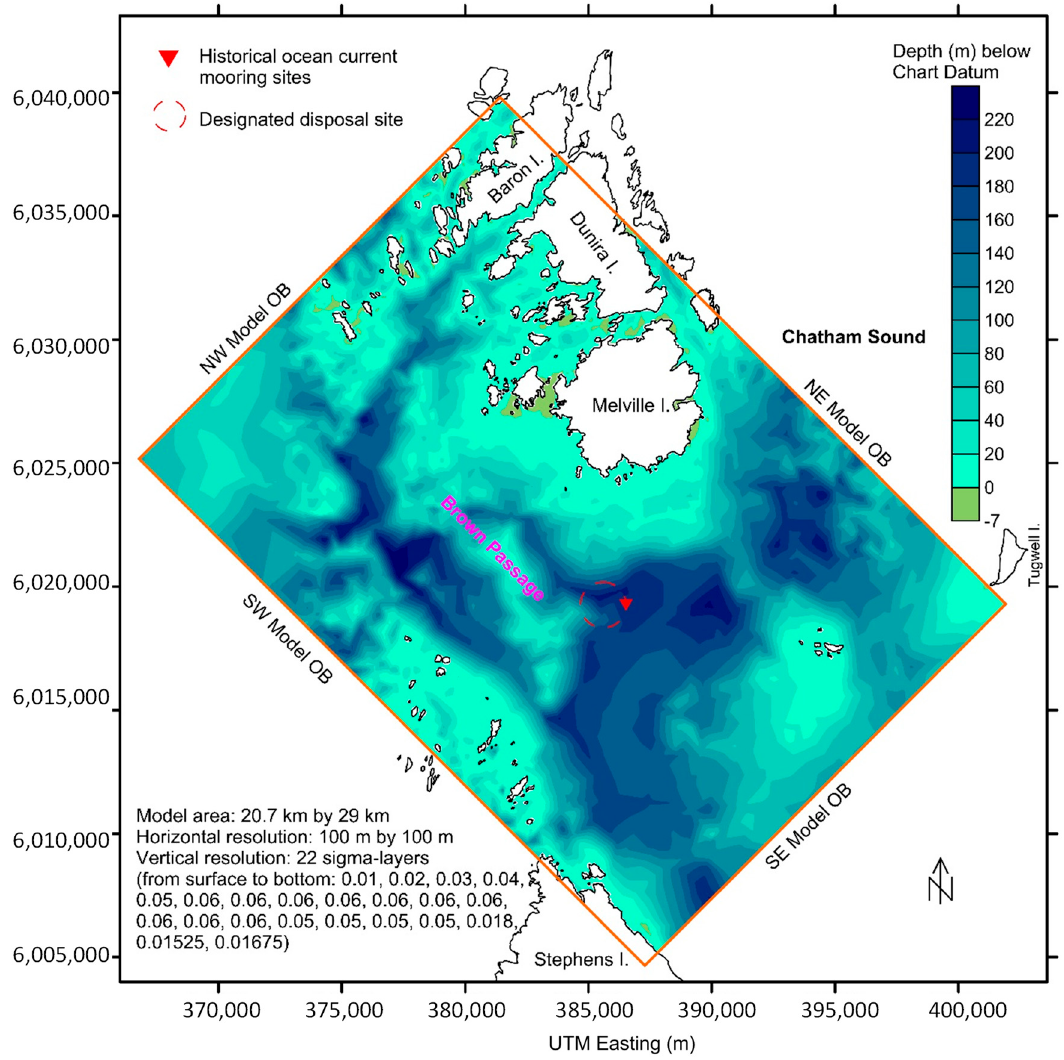
Figure 4. A map of water depths in Brown Passage (meters below chart datum) and the model domain.